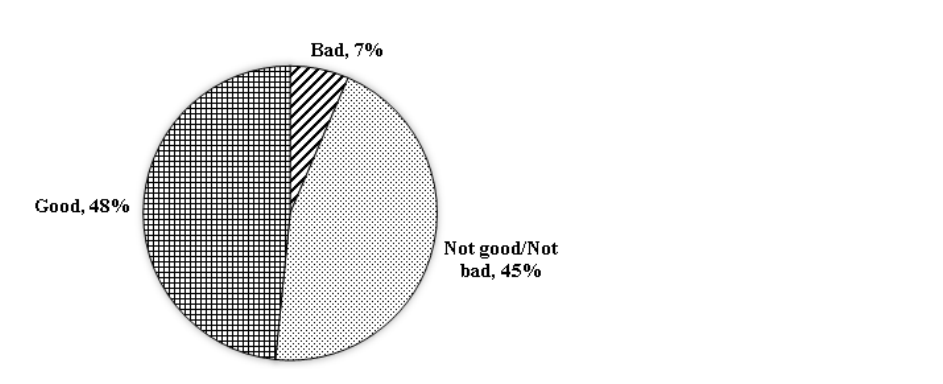
Figure 6. Interview results of the assessment of the impact of construction projects on people’s livelihoods in the surrounding community.